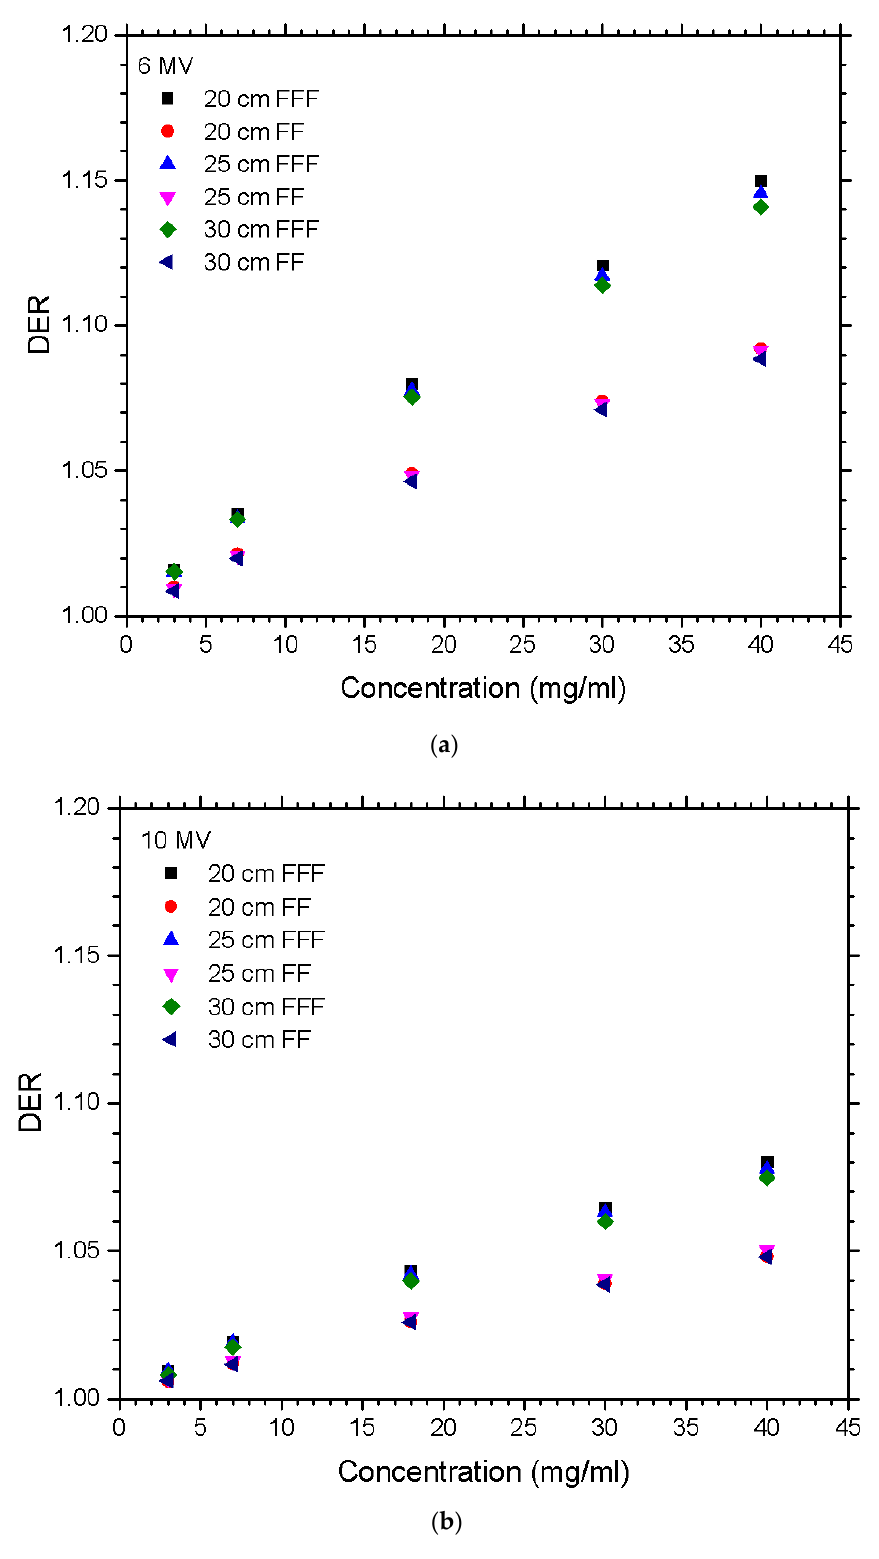
Figure 3. Relationships of the DER and nanoparticle concentration varying with different pelvic sizes using the ( a ) 6 MV and ( b ) 10 MV photon beams. Gold nanoparticles with concentrations equal to 3, 7, 18, 30, and 40 mg/ml were used. The DER was calculated as the ratio of the target dose with nanoparticle addition to the target dose without nanoparticle addition under the same simulation configuration.